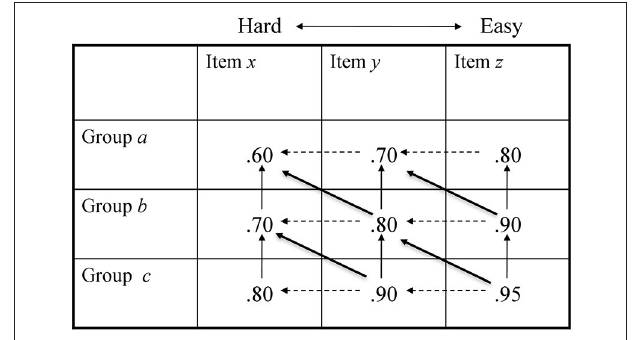
FIGURE 1 | Graphical representation of the single cancelation axiom (row and column